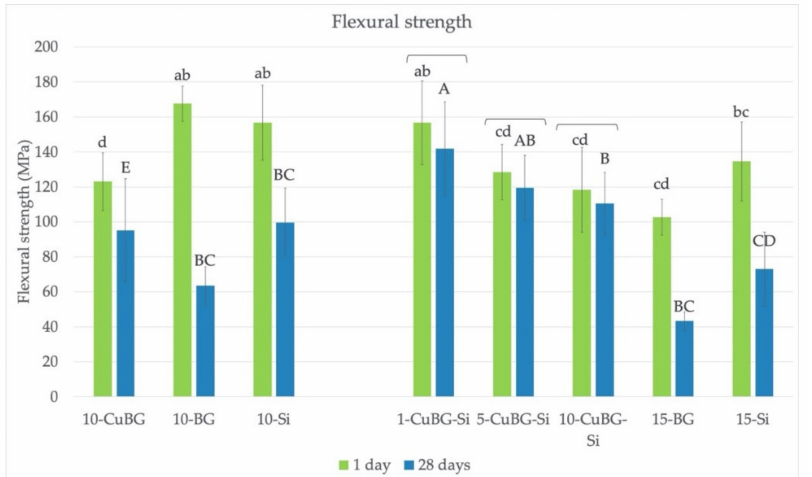
Figure 3. Flexural strength of the tested materials. Lower case letters indicate no statistically signifi- cant differences between groups after 1 day. Upper case letters indicate no statistically significant differences between groups after 28 days. Brackets indicate no statistically significant difference within the same material between 1 and 28 days.